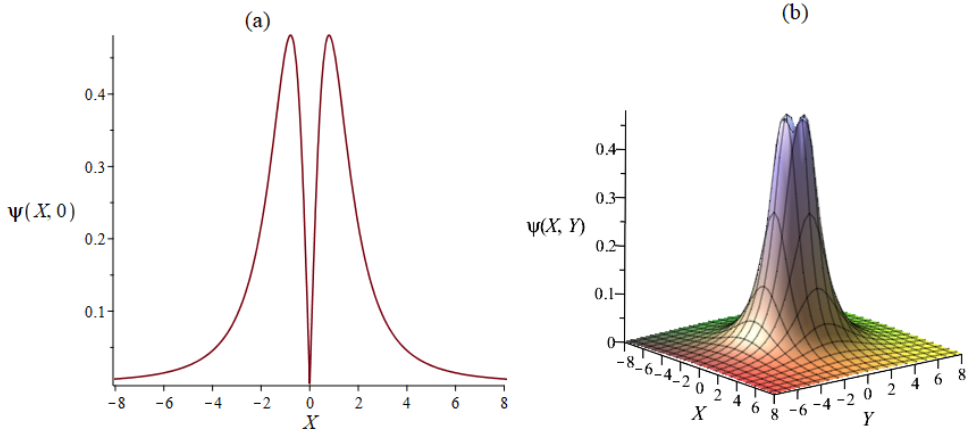
Figure 5. ( a ) Joint probability density Ψ ( X ,0 ) of system (5); ( b ) Joint probability density Ψ ( X , Y ) of system